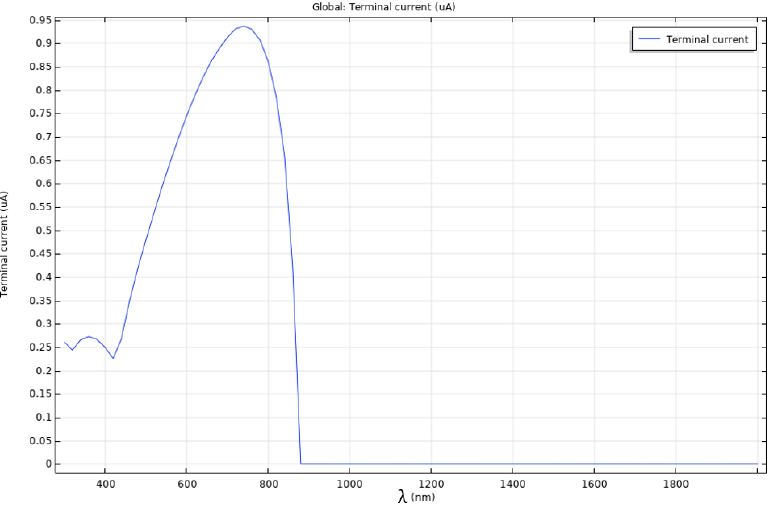
Figure 17. Terminal current measured with respect to frequency for the GaAs absorber layer model, without the nanoantenna.